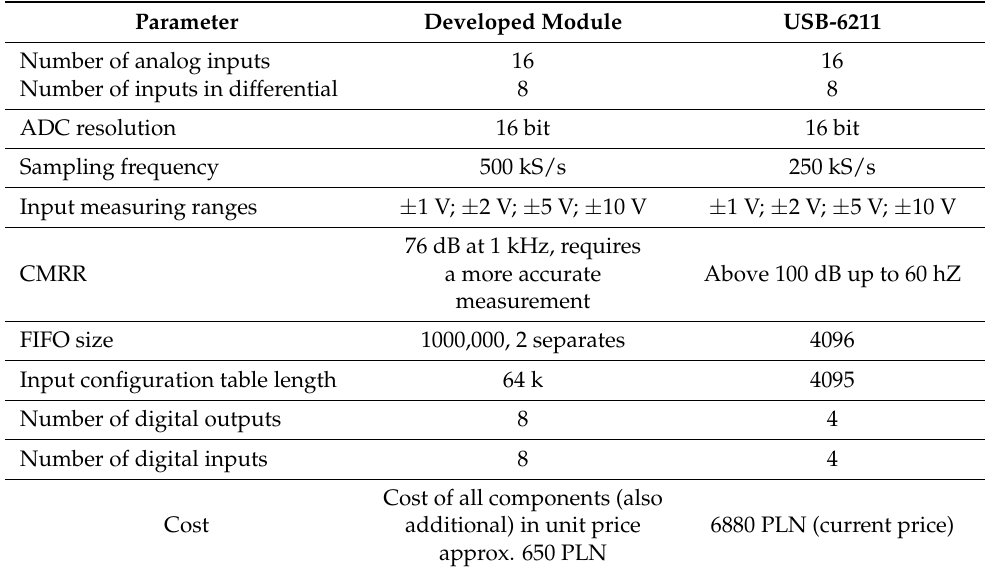
Table 5. Comparison of the parameters of the designed module with the parameters of the commercial National Instruments measurement card model